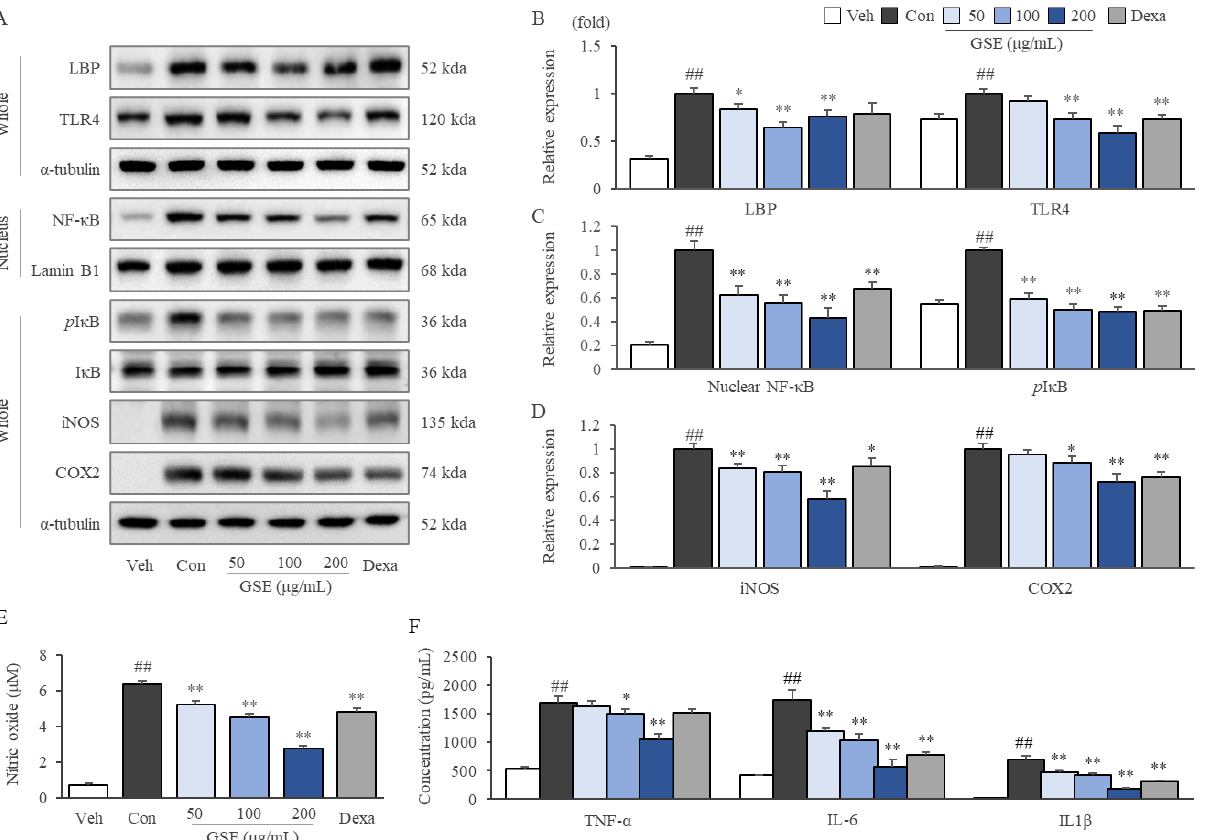
Figure 5. Effects of GSE on the inhibition of TLR4/NF- κ B signaling and inflammatory cytokines in LPS-stimulated RAW264.7 cells. Cells were treated with GSE or vehicle for 2 h, after which LPS (100 ng/mL) was added for 2 h (for NF- κ B and I κ B detection only) or 24 h. Western blot analysis was conducted to evaluate TLR4/NF- κ B signaling pathway-associated proteins in LPS-stimulated RAW264.7 cell lysates ( A ), and the intensities of all bands were quantified by ImageJ ( B – D ). Cell culture supernatants were used to evaluate nitric oxide ( E ) and proinflammatory cytokines ( F ). Samples were grouped according to treatment: vehicle (Veh), control (Con), ginseng sprout extract (GSE), and dexamethasone (Dexa). The data are presented as the mean ± SD. ## p < 0.01 compared with the vehicle group; * p < 0.05, ** p < 0.01 compared with the control group. 2.7. Ginsenoside Rd Inhibited Inflammatory Cytokines and Mediators by Suppressing the Nuclear Translocation of NF- κ B in LPS-Stimulated RAW264.7 Cells Ginsenoside Rd and Re showed nontoxicity up to 50 and 100 µ M, respectively (Figure 6A). Interestingly, low concentrations of Rd (12.5 and 25 µ M) significantly increased cell proliferation. (Figures 6A and S1E). Rd (50 µ M) treatment significantly inhibited the pro- duction of NO, and the expression of TNF- α , IL-6, and IL-1 β in LPS-stimulated RAW264.7 cells compared to the control group ( p < 0.01 for all parameters). Additionally, these anti- inflammatory effects were observed to a smaller extent after treatment (Figure 6B,C). Rd dominantly (and Re slightly) suppressed the nuclear translocation of NF- κ B compared to the control group ( p < 0.01) (Figure